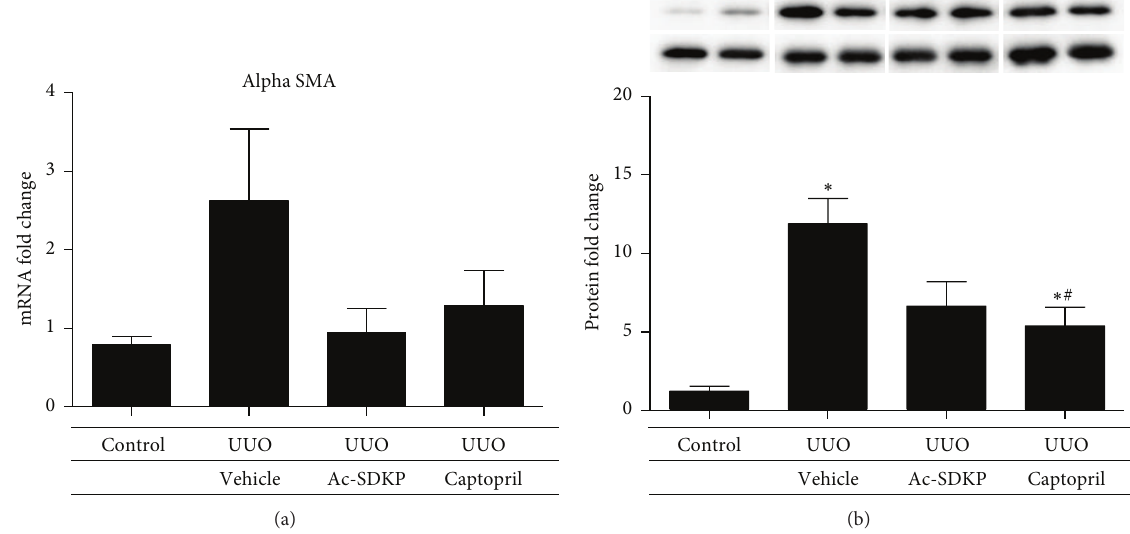
Figure 8: Alpha smooth muscle actin expression in renal cortical tissue. (a) Quantitative analysis of mRNA expression by qPCR. (b) Quantitative analysis of protein expression of different groups, with representative Western blot gels shown in duplicate at the top. MCP-1